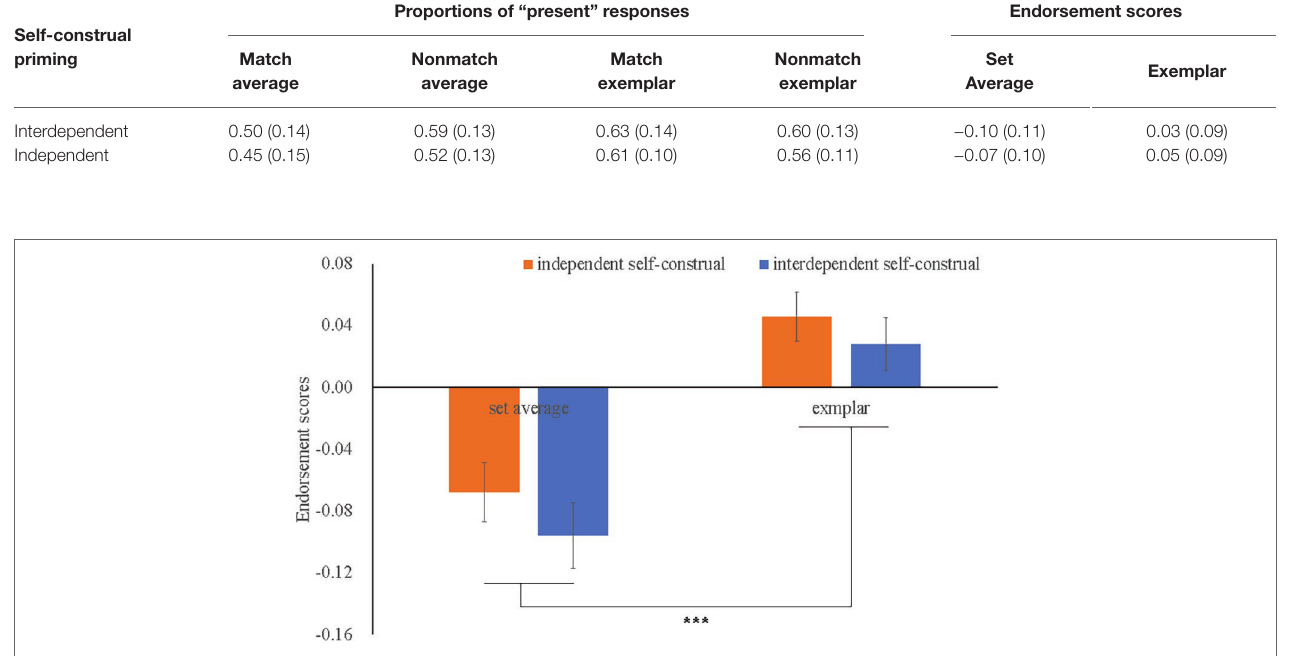
FIGURE 4 | Endorsement scores as a function of Prime Type × Testimage Type in Study 2. Error bars refer to SME. *** refers to the significant Testimage Type effect ( p <